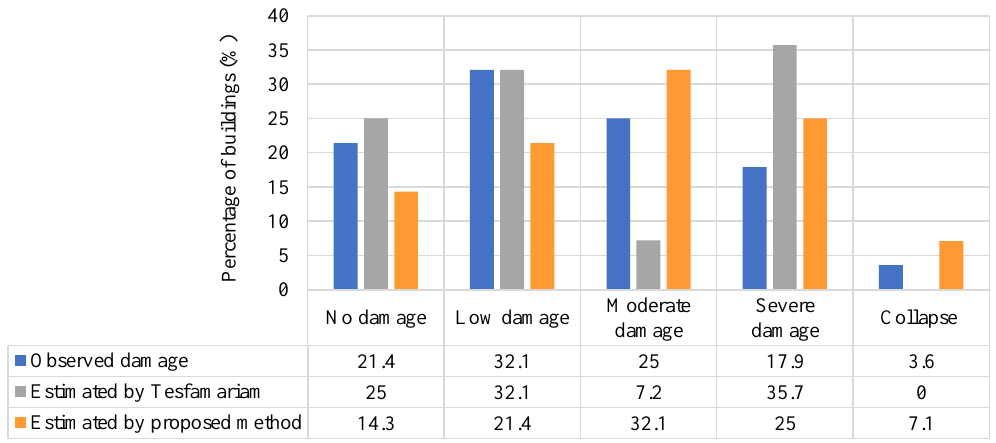
Figure 4. Damage state of selected building data of Bingöl from RVS methodologies.